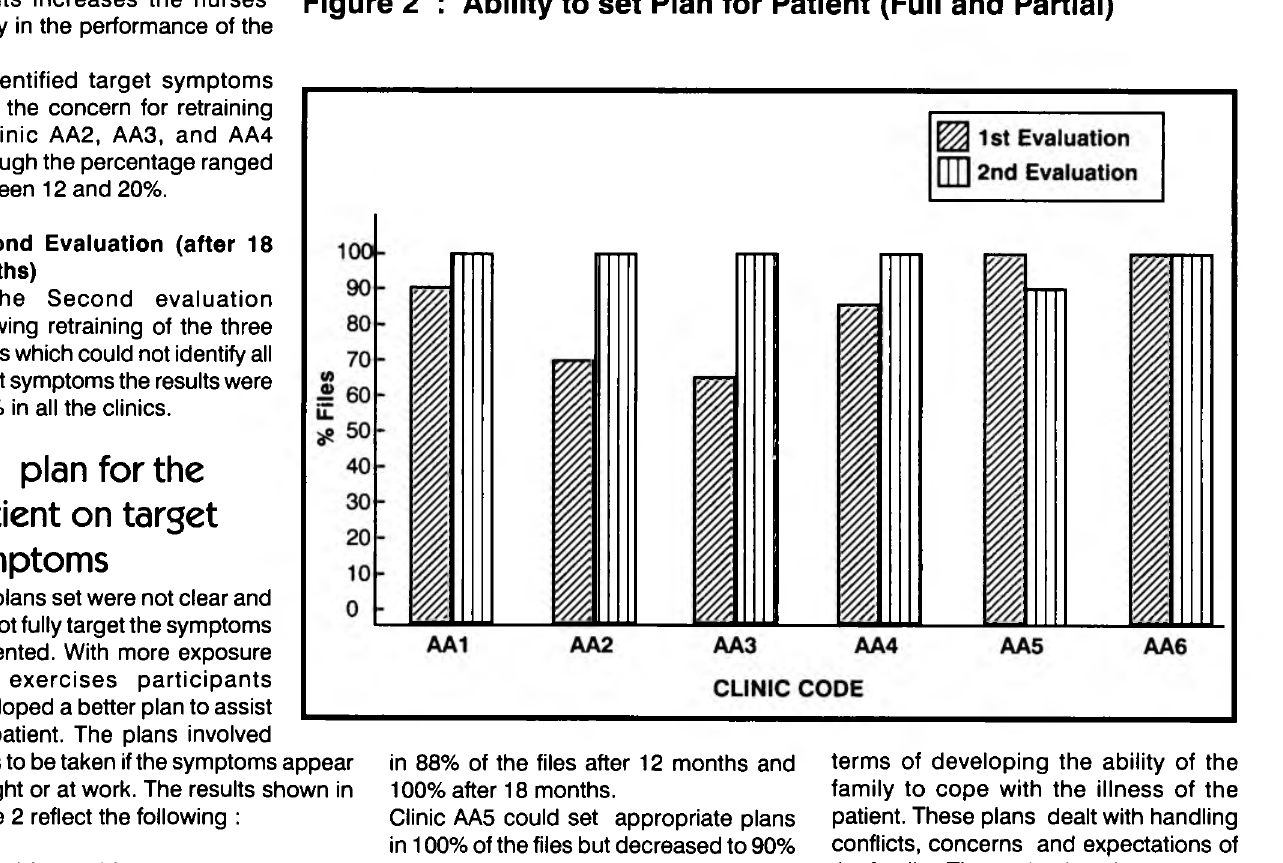
Figure 2 : Ability to set Plan for Patient (Full and Partial) results increases the nurses'